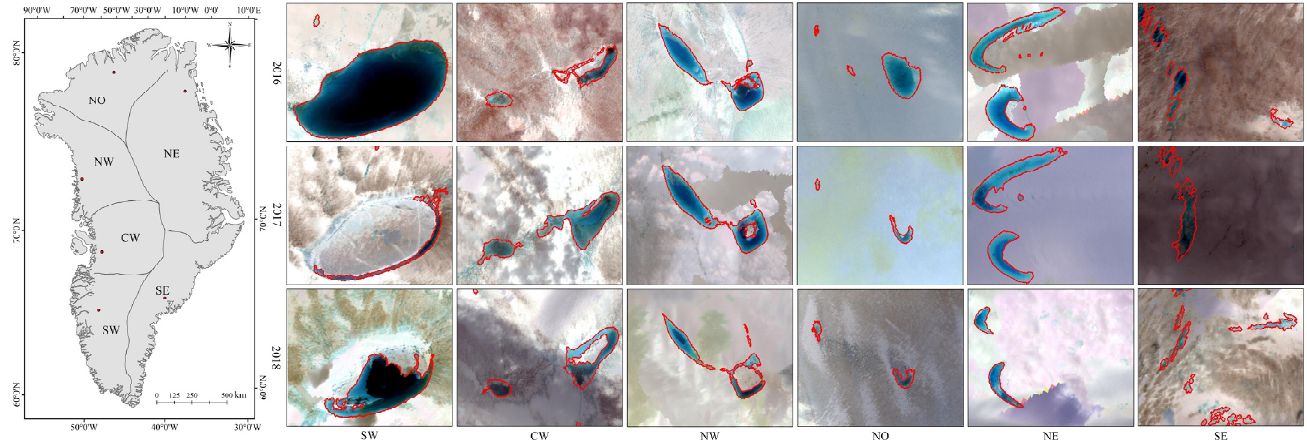
Figure 4. SGL extraction results of Greenland during the 2016–2018 melt seasons. The left subfigure marked in red shows the locations of detailed sub-regions; the red boundaries in the right subfigure stand for the extracted SGL contours. The background image is the Sentinel-2 (10 m) true-color average performance image acquired during the melt seasons of 2016, 2017, and 2018.